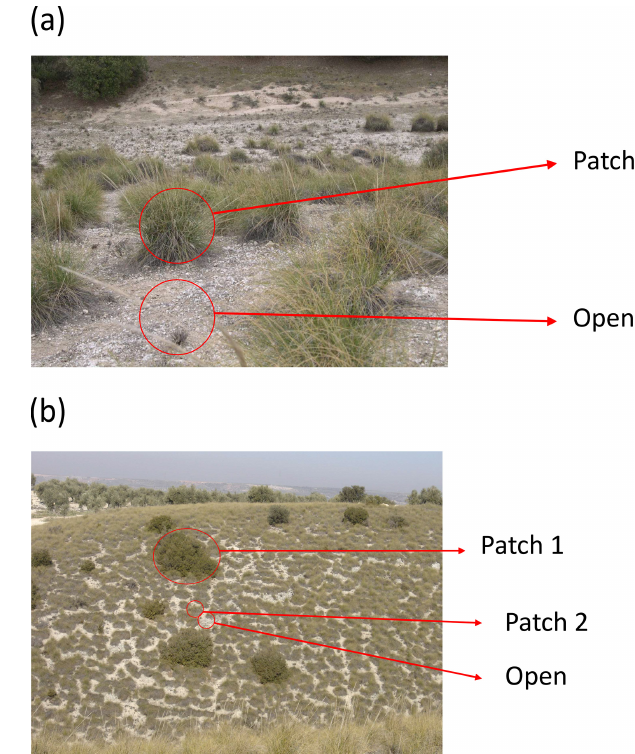
Figure 13. Example of layout of sampling areas in a plant patch and in an adjacent bare ground area (“Open”) (a) and in areas with dif- ferent types of plant patches and in an adjacent bare ground area (b) . Photographs by Fernando T.